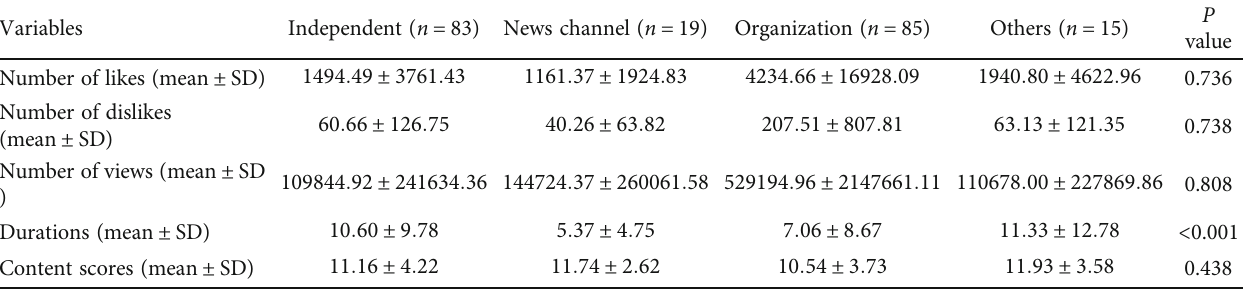
Table 7: Analysis of variables in relation to YouTube content publishers on hydroponic technology.